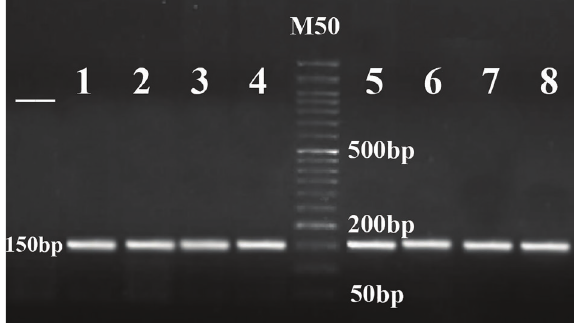
Figure 3. Electrophoresis of studied samples using GAPDH primers in Kermani sheep on agarose gel. M50: size marker. Lanes 1 – 8 are brain, heart, lung, spleen, kidney, liver, ovary and testis, respectively. – : negative